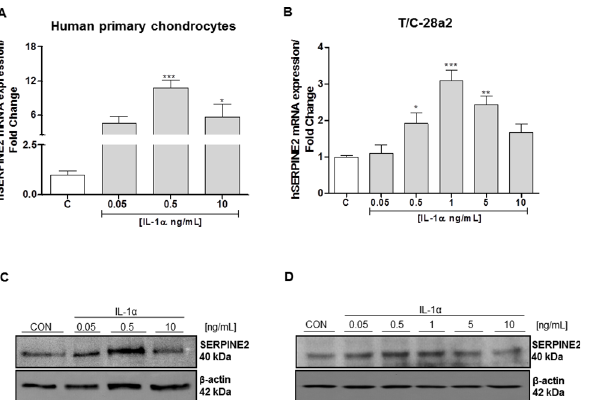
Fig 1. mRNA and protein expression of SERPINE2 were determined by real-time PCR and western blot analysis respectively. A, B . Human SERPINE2 mRNA expression after interleukin IL-1 α treatment (0.05 – 10 ng/mL) during 24 hours in human primary chondrocytes and in T/C-28a2 chondrogenic cells. C, D . Representative western blot of human SERPINE2 protein expression in lysates obtained from human primary chondrocytes and T/C-28a2 chondrogenic cells treated with interleukin IL-1 α (0.05 – 10 ng/mL) for 24 h. β -actin was used to ensure equal sample loading. Data are means ± S.E.M. of at least 3 independent experiments. * P < 0.05, ** P < 0.01 and *** P < 0.001 vs untreated control